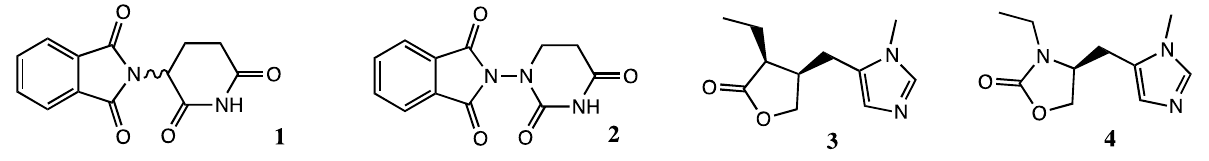
Figure 1. Thalidomide ( 1 ), pilocarpine ( 3 ) and their aza-analogs 2 and 4 .